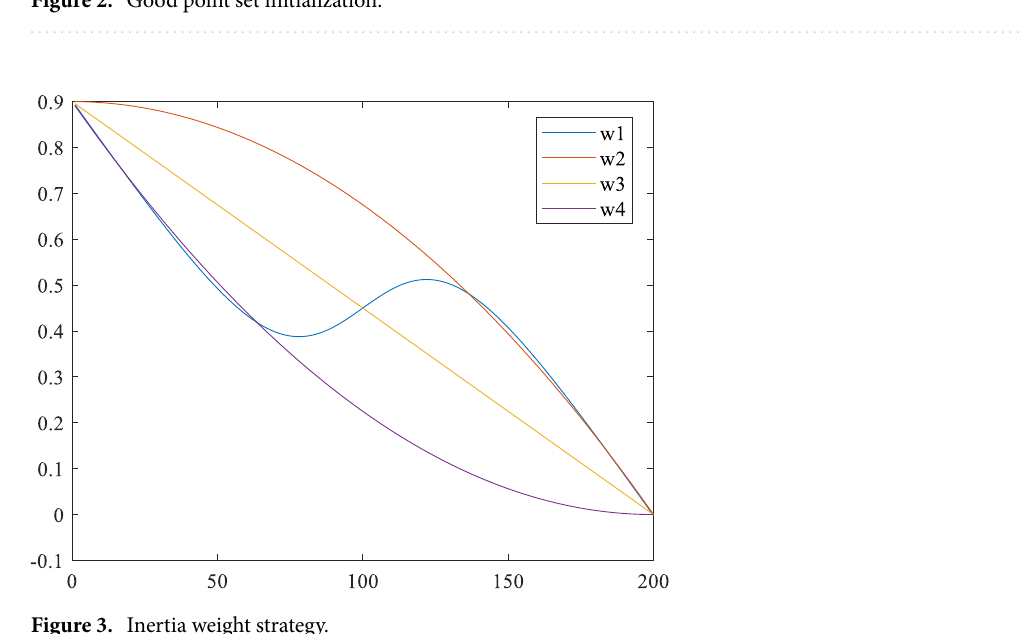
Figure 3. Inertia weight